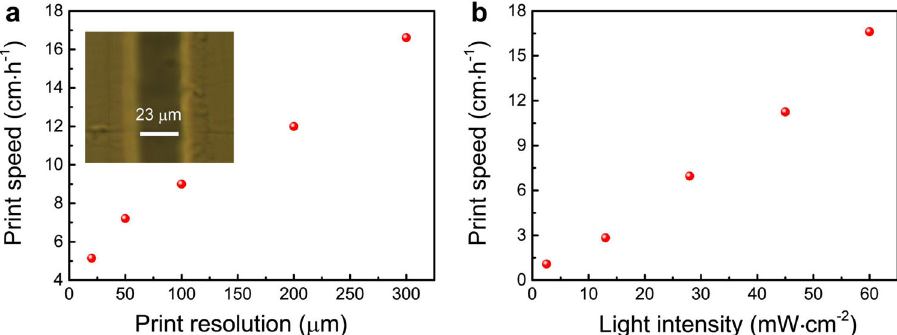
Fig. 3 High print resolution and speed enabled by photooxidation of KCD. Print speed against a print resolution and b light intensity of 420 – 780 nm light. Inset of a Optical microscope image (Axio Scope A1, Carl Zeiss) of the 3D-printed line photomediated by the KCD/TA